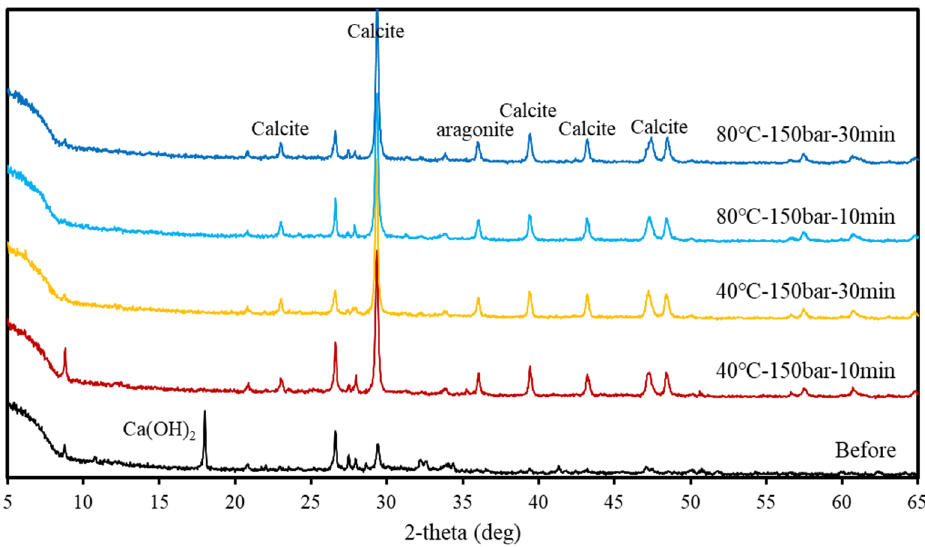
Figure 8. XRD patterns obtained at 150 bar.